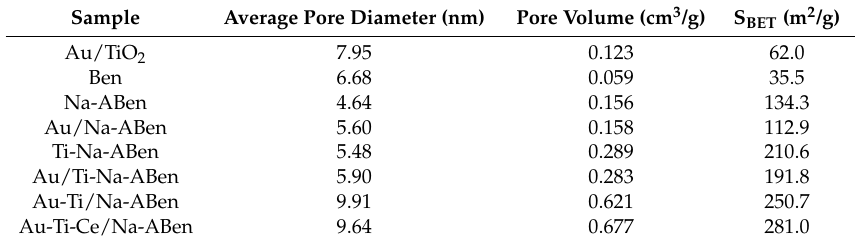
Table 3. Brunauer–Emmet–Teller (BET) surface area, pore volume, and average pore size of the